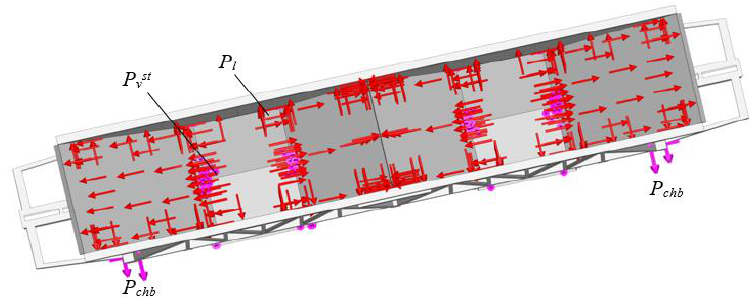
Figure 22. Calculation scheme of the hopper wagon.